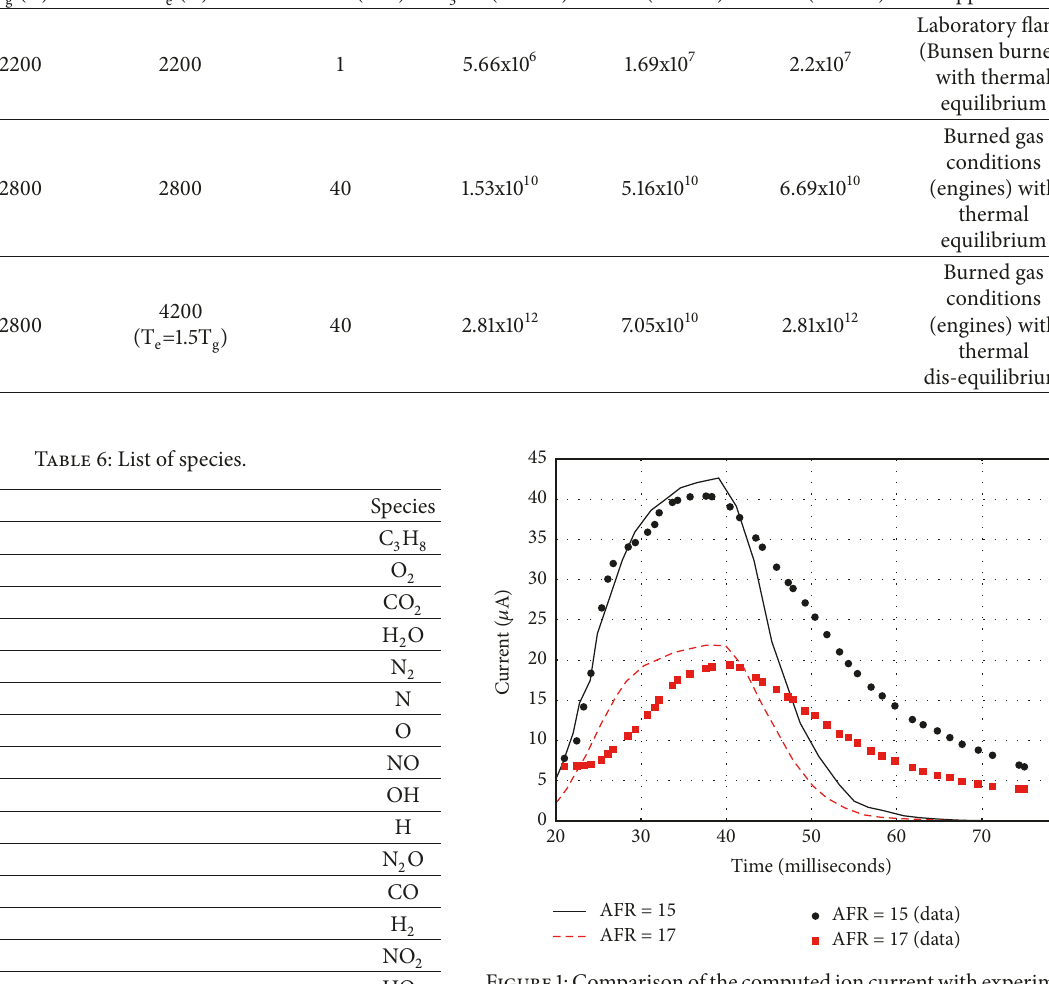
Figure1:Comparisonofthecomputedioncurrentwithexperimen- tal data in a constant volume cylinder (CH 4 -air mixture, air-fuel- ratio (AFR) = 15 & 17)